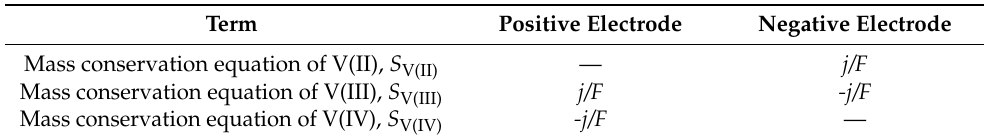
Table 2. Source terms of the governing equations. Term Positive Electrode Negative Electrode Mass conservation equation of V(II), S V(II) — j/F Mass conservation equation of V(III), S V(III) j/F -j/F Mass conservation equation of V(IV), S V(IV) -j/F —